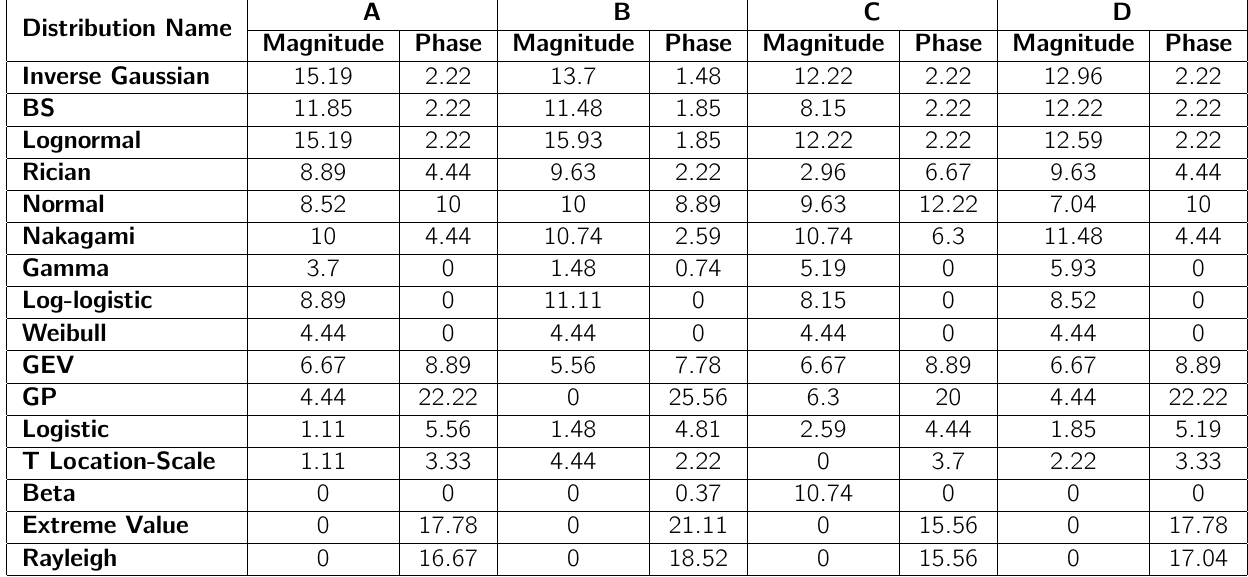
Table 2: The percentage of times each distribution fell within the top 3 best-fit candidates for each element of the cascaded random variable ABCD matrix, Γ . BS-Birnbaum-Saunders. GEV-Generalized Extreme Value, GP-Generalized